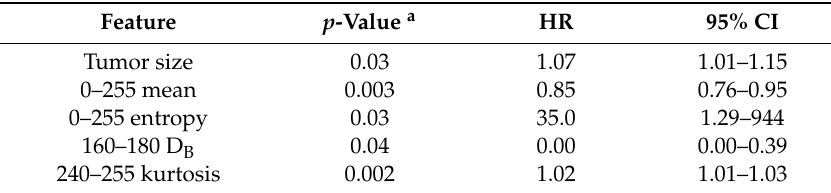
Table 3. Evaluation of the prognostic independence for image analysis features a